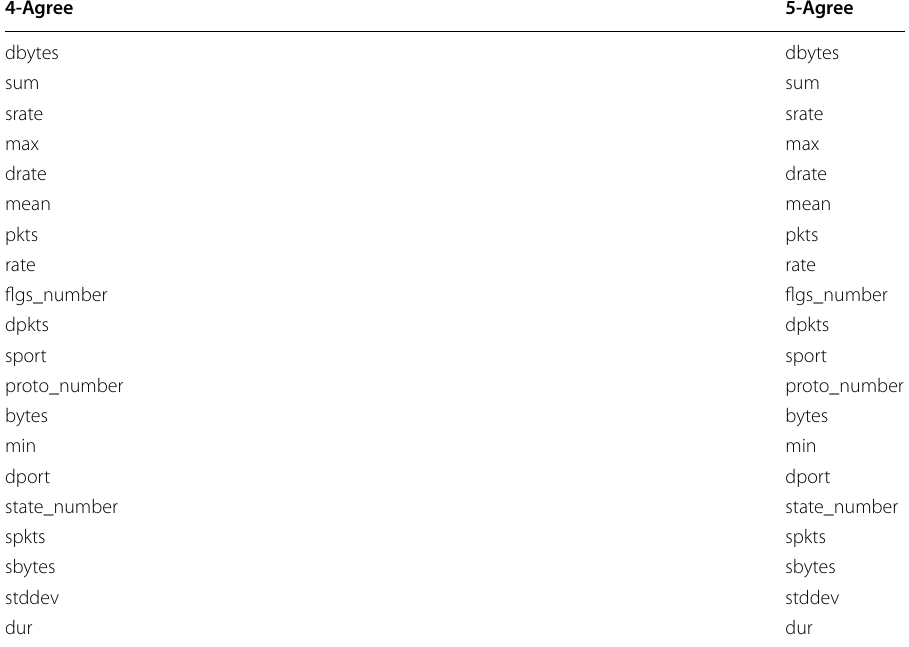
Table 49 Results of the 4-Agree and 5-Agree FSTs 4‑Agree